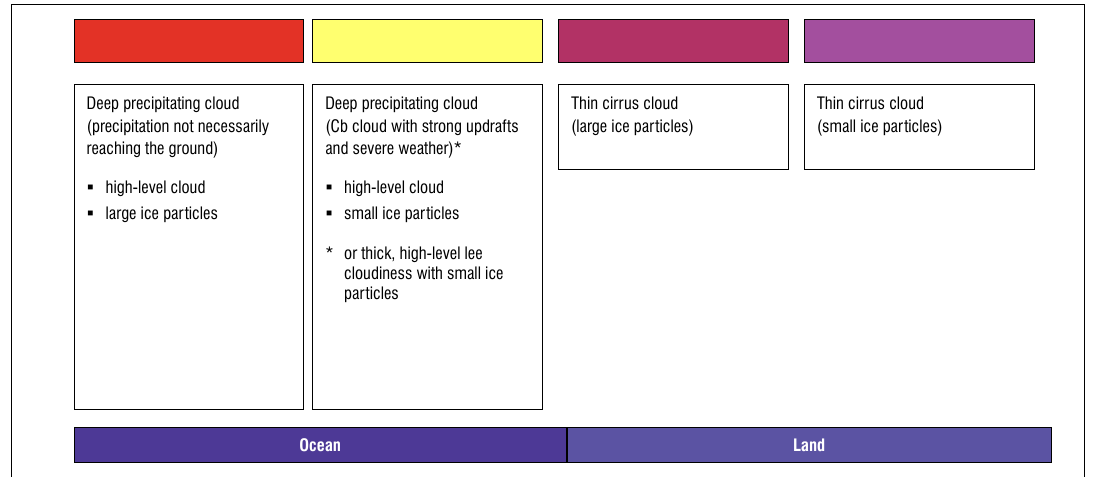
Ocean Land Description of the colour interpretation for the convection red-green-blue colour palette.